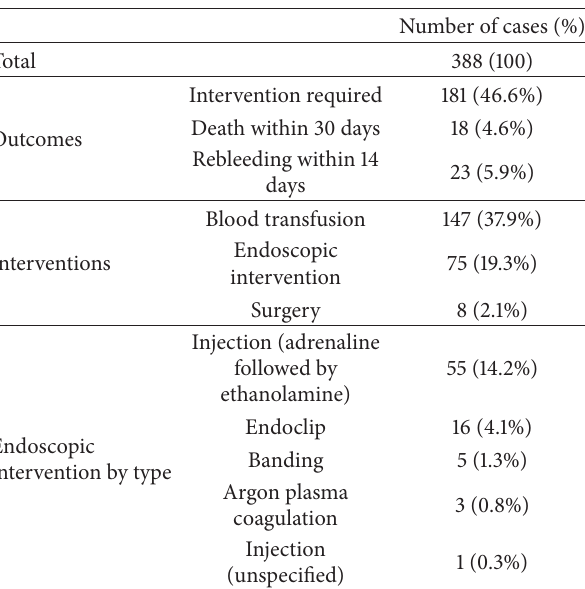
Table 2: Outcomes and